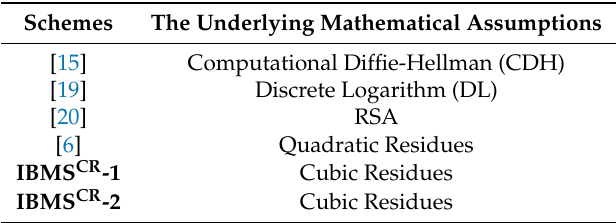
Table 1. The comparison of related work on the security assumptions.